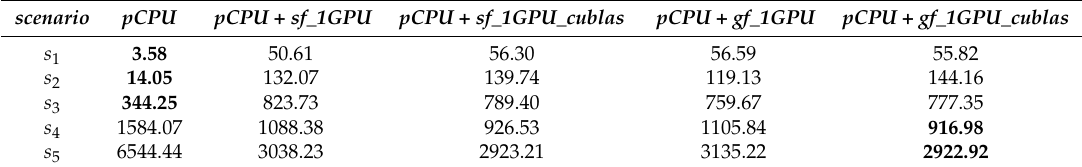
Table 3. Execution times (in seconds, for 10 iterations) in saturno (the best time value for each scenario has been highlighted).